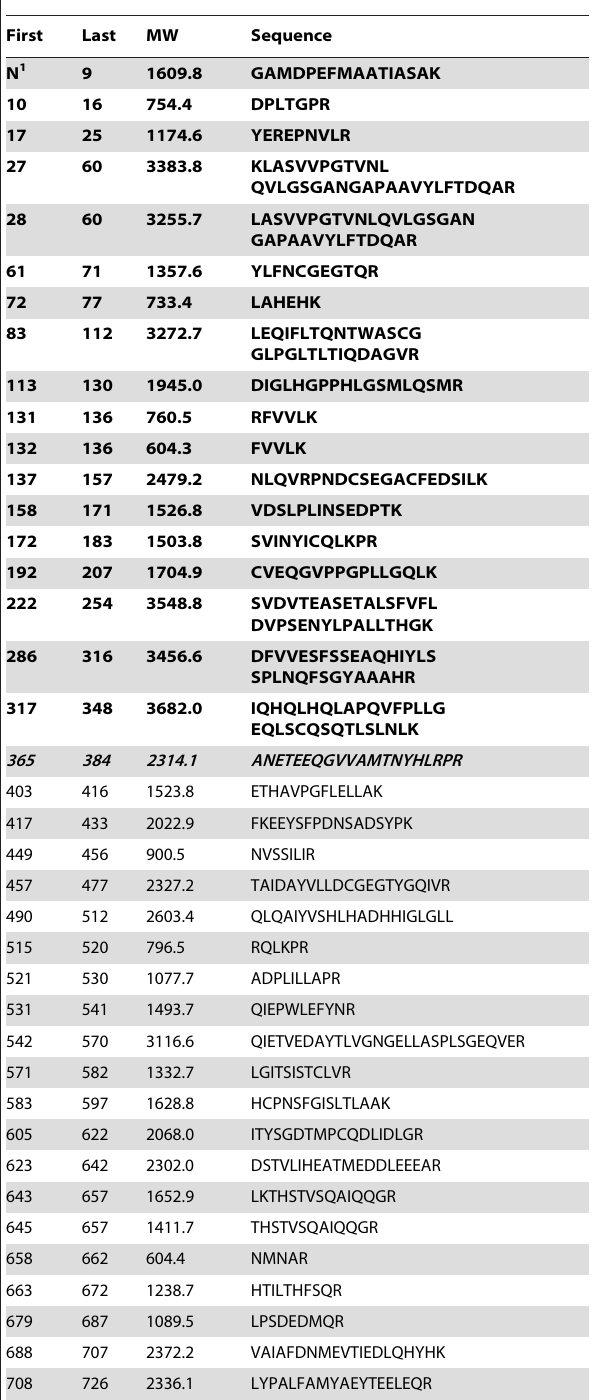
Tryptic Peptides from 2D gel spots were analyzed by MALDI-Ion trap MS. All peptides listed are found in full length tRNase Z. Bold: N dom and tether peptides are found in full length tRNase Z but not in C dom 2 region. Italic: Absence of peptide 365–384 from C dom 2 defines the amino boundary of the C dom 2